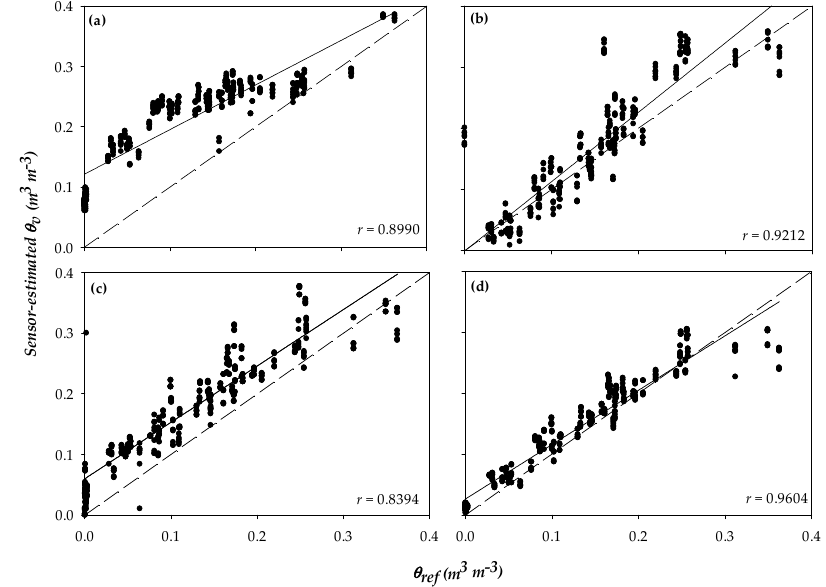
Figure 3. Pearson correlation coefficient ( r ) between soil volumetric water content ( θ v ) measured by sensors using the generic equation provided by the manufacturer and determined by gravimetry ( θ ref ) for the Meter Group sensors 10HS ( a ), GS1 ( b ), GS3 ( c ), and the 5TE ( d ). The solid line is the fitted Pearson’s correlation, and the dashed line is the 1:1 reference. Each point represents a single data value taken from each of the three replications by soil series, soil depths, amount of water added, and evaluated sensors ( n = 540).